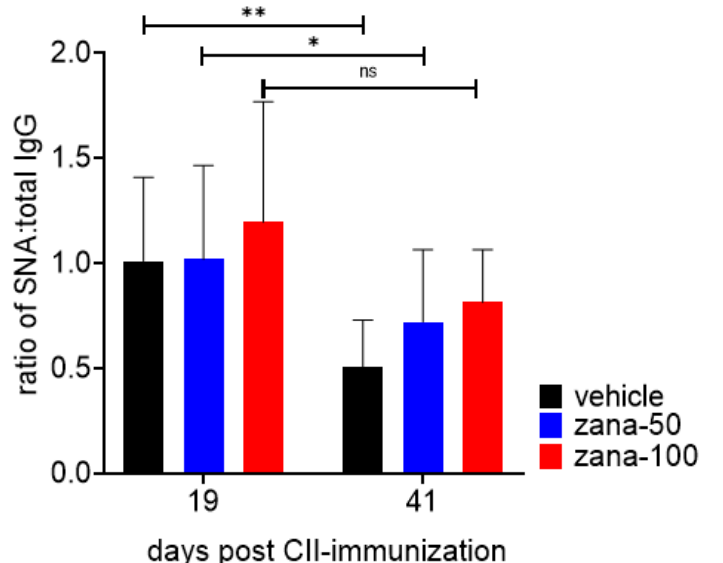
Figure 4. High-dose zanamivir inhibits the decrease in IgG sialylation in the arthritic phase of CIA. Levels of (2,6)-SA residues on total serum IgG were measured by ELISA using biotinylated Sambucus nigra, a lectin specific for terminal-linked (2,6)-SA. IgG sialylation is expressed as ratio of SNA binding (OD) to total IgG concentration. Results are shown as ± standard deviation ( ± SD). * p < 0.05, ** p < 0.01; ns = not significant. Two-way ANOVA for repeated measures with Sidak’s multiple comparisons test was used.